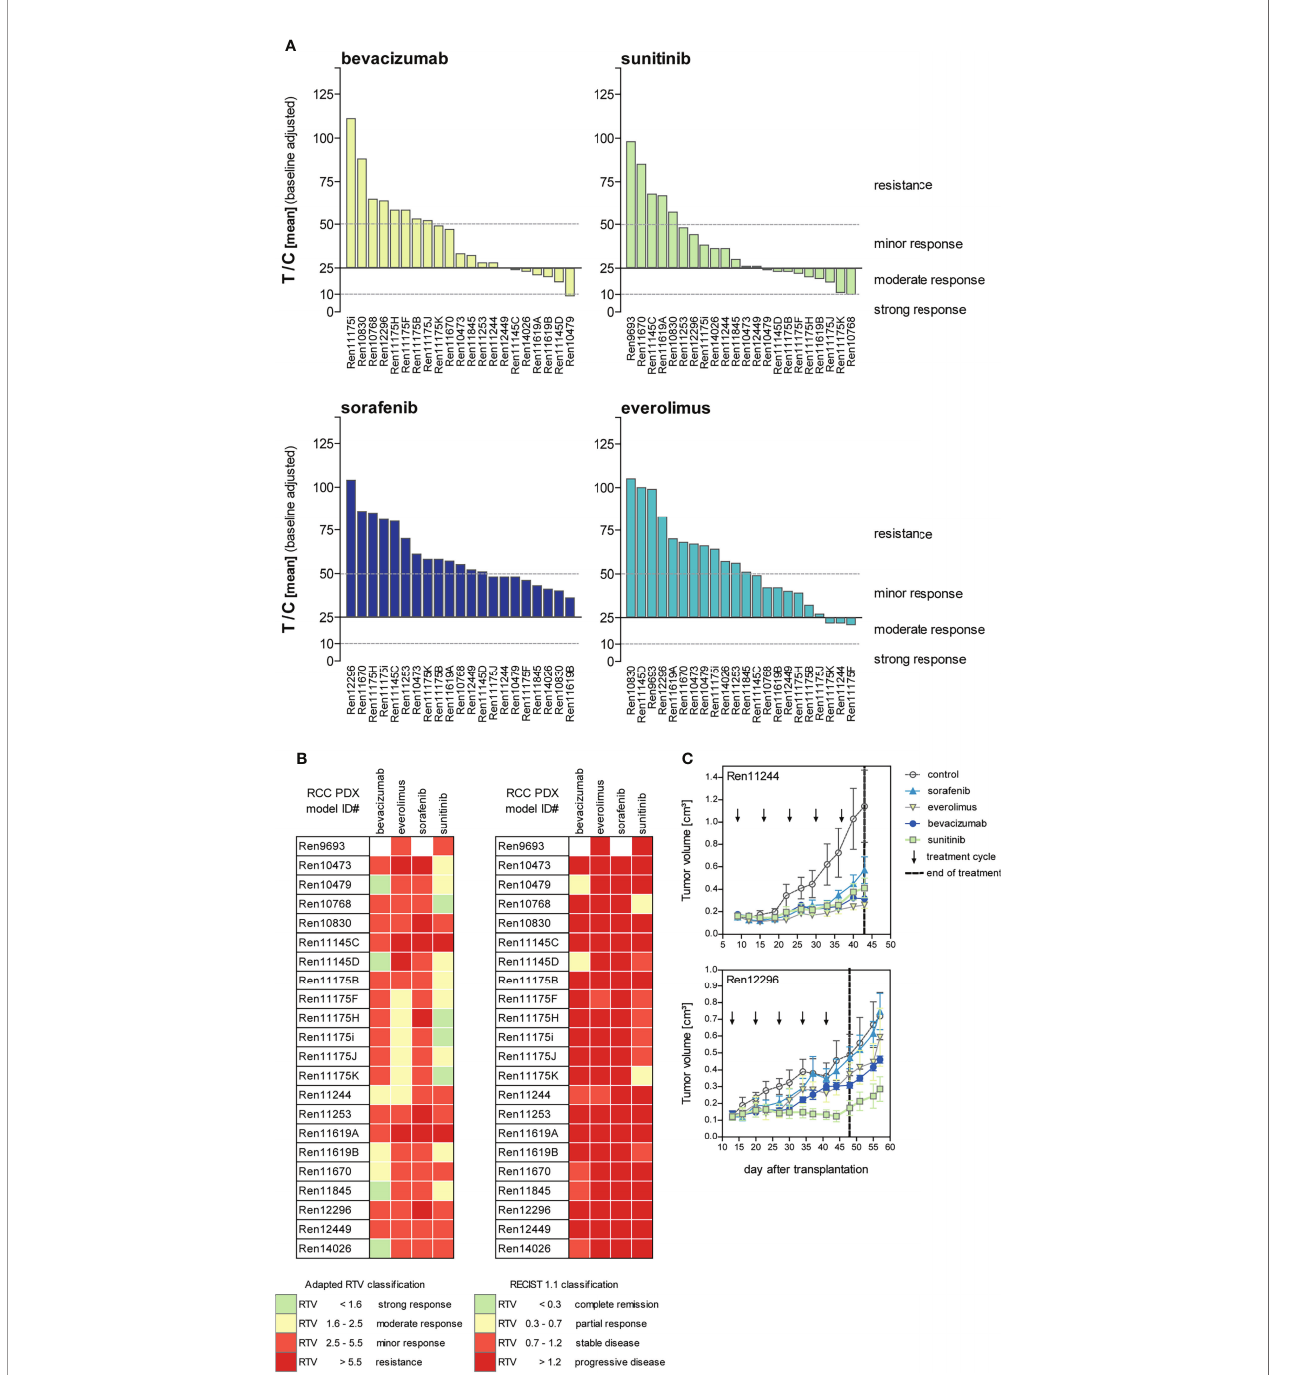
FIGURE 4 | Response characterization of renal cancer PDX models upon treatment with targeted therapies blocking angiogenic and proliferative pathways. (A) Mean tumor volume of treated mice compared to the mean tumor volume of control (T/C mean) from 22 PDX sensitivity studies (n = 3 – 5 individual animals per group) were illustrated in waterfall plots. Bevacizumab and sorafenib were not tested in Ren9693. Response was categorized as T/C: >50% = resistance/progressive disease (PD), <50% >30% = minor response/stable disease (SD), <30% >10% = moderate response/partial response (PR), and <10% = strong response/complete remission (CR) with zero line equal to T/C = 25%. In the 22 analyzed PDX models, treatment response was best for sunitinib, followed by bevacizumab and everolimus. Lowest response rate was observed for sorafenib. (B) Individual PDX models exhibit distinct response pattern against selected compounds. Adapted response criteria utilizing RTV (left) opposed to clinical RECIST response classi fi cation (right). Adapted RTV response classi fi cation mirrors T/C drug response well, whereas clinical RECIST classi fi cation yields dramatic lower responses. (C) Different response patterns were observed for individual RCC PDX models during drug testing, illustrating RCC heterogeneity and differences of intra-tumoral